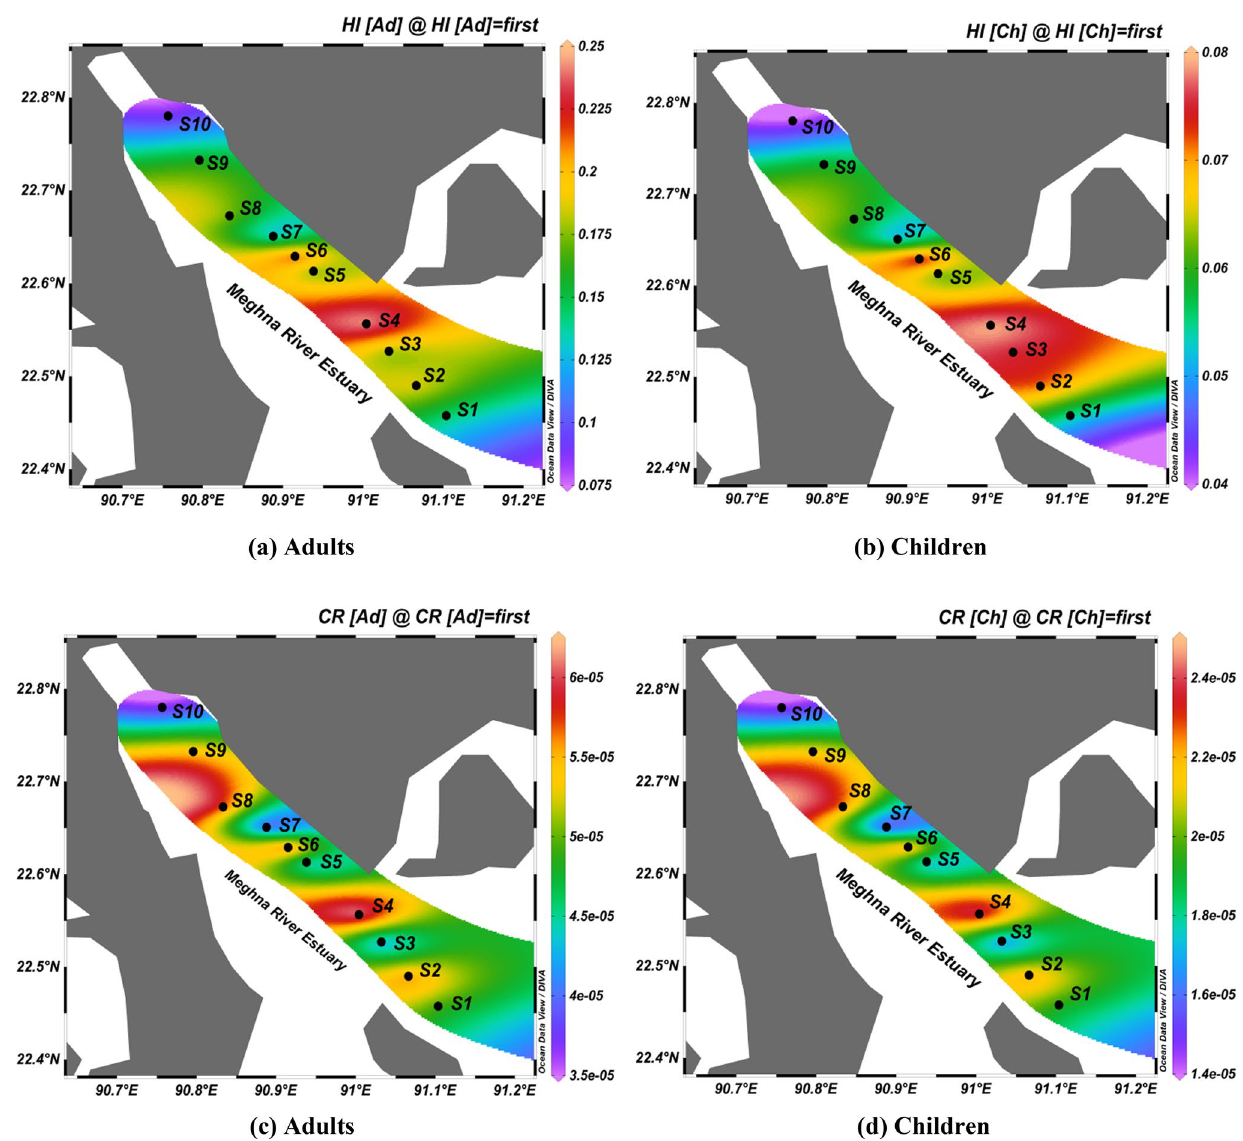
Fig. 4 Hazard index of adults and children along with the river estuary ( a , b ) and carcinogenic risk of nearby dwellers of the selected sites ( c , d